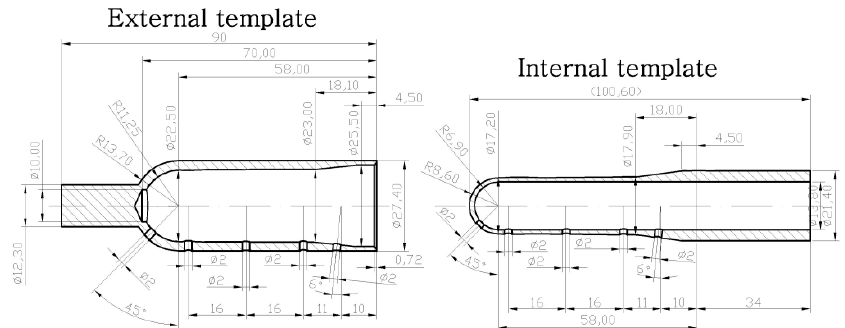
Figure 4. Dimensions of templates used for marking, marked on the outside and inside walls of the preform, used to define the coefficients of the bottle blow kinetics.